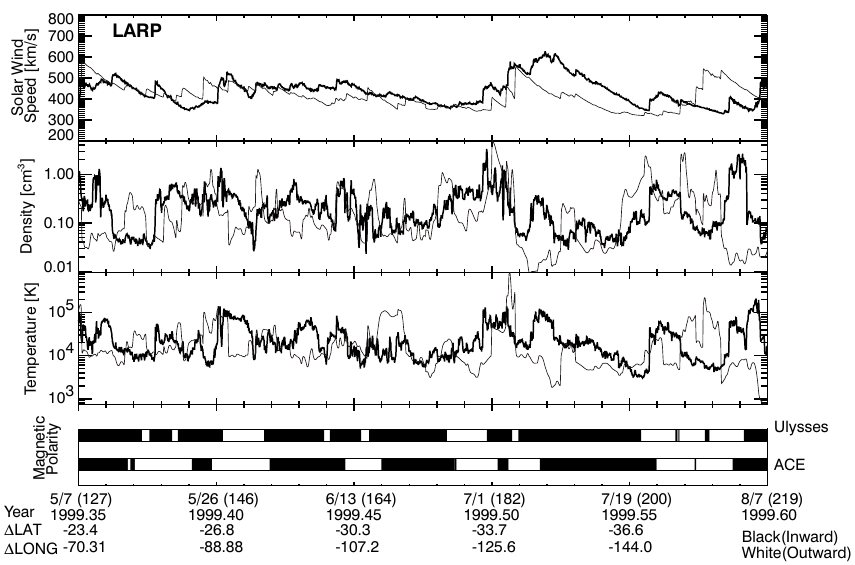
The bottom three panels of Fig. 1 compare Ulysses density (third panel), temperature (fourth panel), and magnetic po- larity (bottom panel) measurements to the LARP ACE